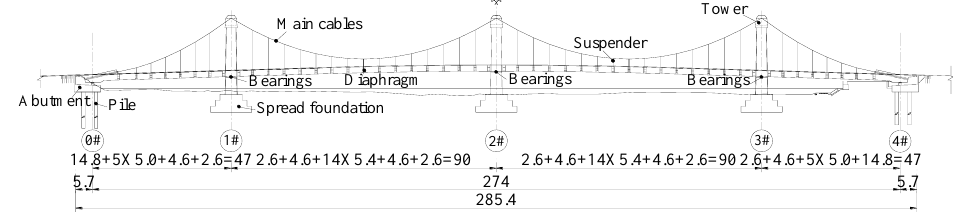
Figure 1. General layout of the bridge (unit: m).